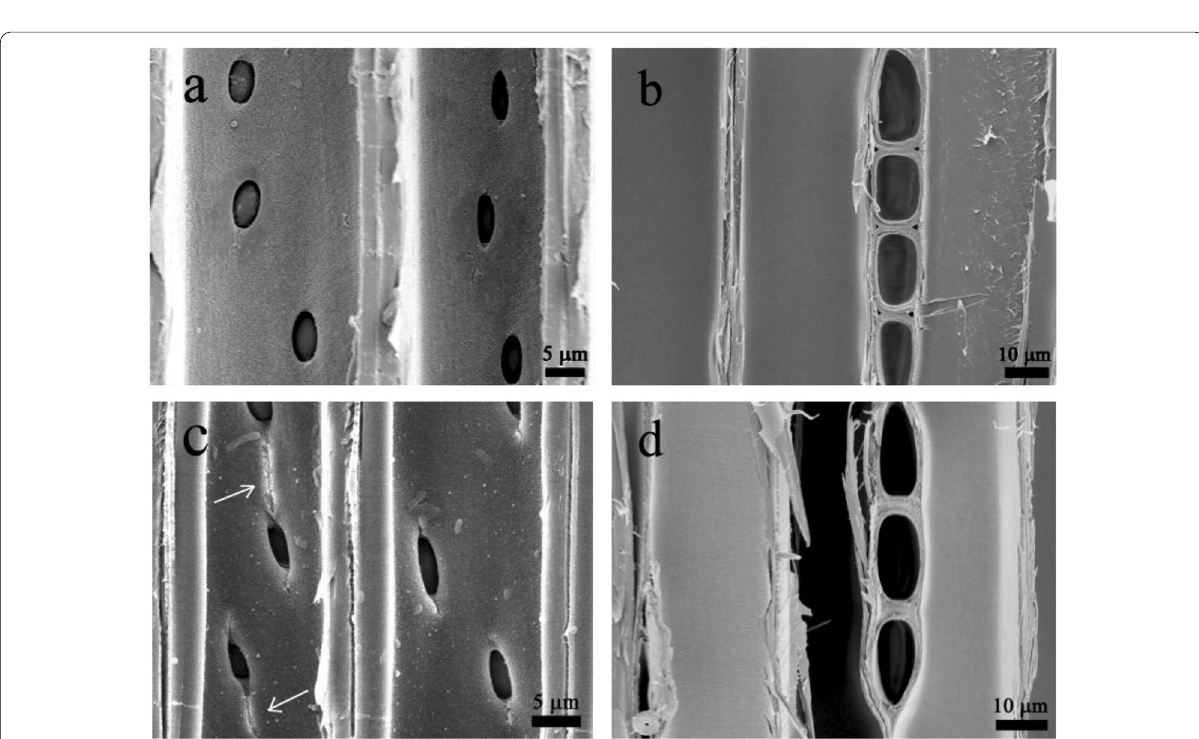
Fig. 7 SEM images of longitudinal tracheids and ray cells: a radial section of control sample; b tangential section of control sample; c radial section of MW-pretreated sample; and d tangential section of MW-pretreated